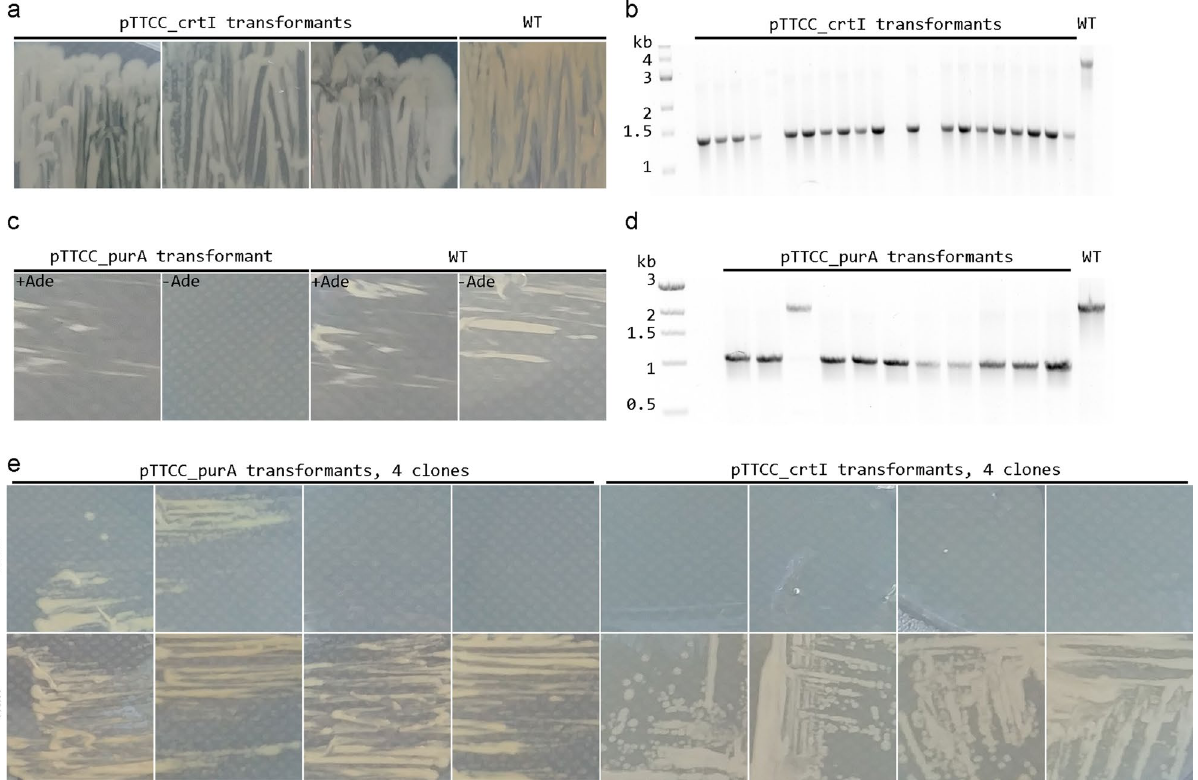
Figure 4. CaldoCas9 based genome editing of T. thermophilus at 65 °C. ( A ) pTTCC_crtI transformants streaked out on fresh media and grown overnight to reveal pigmentation difference in the transformants and WT cells. ( B ) Agarose gel electrophoresis of products from colony PCR amplification of the genomic locus containing crtI in T. thermophilus pTTCC_crtI transformants. Expected band size of the KO allele was 1351 bp and of WT allele 2891 bp. ( C ) pTTCC_purA transformants streaked out on minimal media with and without adenine supplementation (+ Ade − Ade, respectively) to reveal the adenine auxotrophic phenotype. ( D ) Agarose gel electrophoresis of products from colony PCR amplification of genomic locus containing purA in T. thermophilus pTTCC_purA transformants. Expected band size of the KO allele was 1094 bp and the WT allele 2320 bp. ( E ) After growth of pTTCC_purA and pTTCC_crtI transformants in media without antibiotic selection, individual colonies were streaked out on media with and without kanamycin (+ Kan, − Kan, respectively) to reveal the presence or absence of the plasmid. The agarose gel images ( B , D ) have been digitally manipulated for clarity. The original images are provided in supplementary file